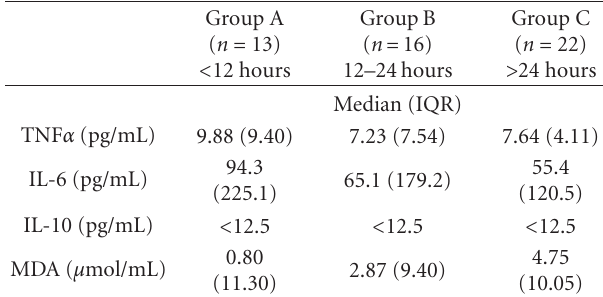
Table 2: Serum concentrations of tumour necrosis factor-alpha (TNF α ), IL-6, IL-10, and malondialdehyde (MDA) of 51 septic pa- tients in relation to the time of blood sampling from advent of